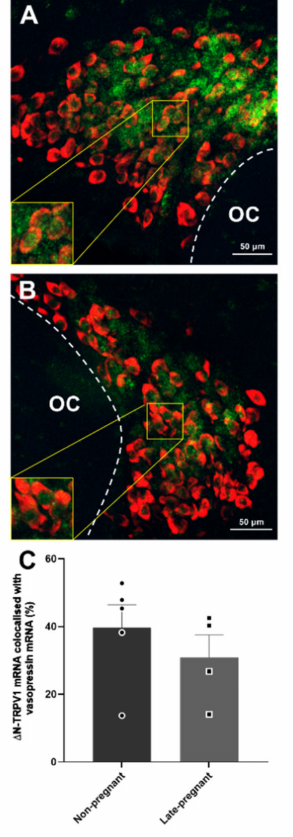
Figure 8. Vasopressin mRNA and ∆ N-TRPV1 mRNA expression in the supraoptic nucleus of non- pregnant and late-pregnant rats. ( A , B ) Example compressed Z-stacks of vasopressin mRNA (red) and ∆ N-TRPV1 mRNA (green) labelling in the supraoptic nucleus of non-pregnant ( A ) and late-pregnant ( B ) rats. OC: optic chiasm. ( C ) Mean levels of ∆ N-TRPV1 mRNA and vasopressin mRNA co-labelling in the supraoptic nucleus of non-pregnant and late-pregnant rats. There was no difference in ∆ N- TRPV1mRNA expression ( p = 0.66, unpaired t -test), vasopressin mRNA expression ( p = 0.71), or co-expression of ∆ N-TRPV1 mRNA and vasopressin mRNA between non-pregnant and late-pregnant rats ( p =